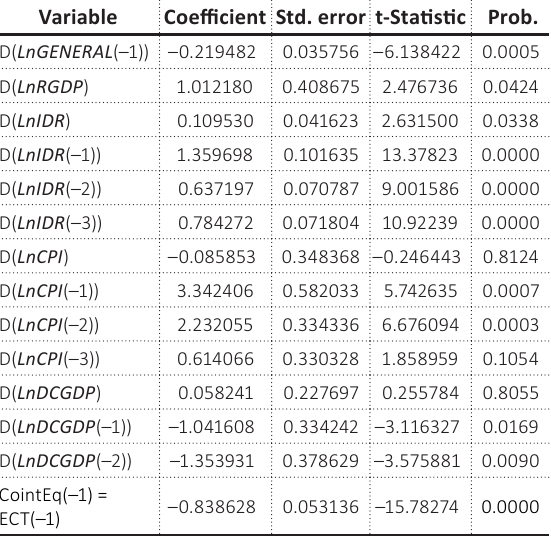
Table 5. ARDL error correction regression